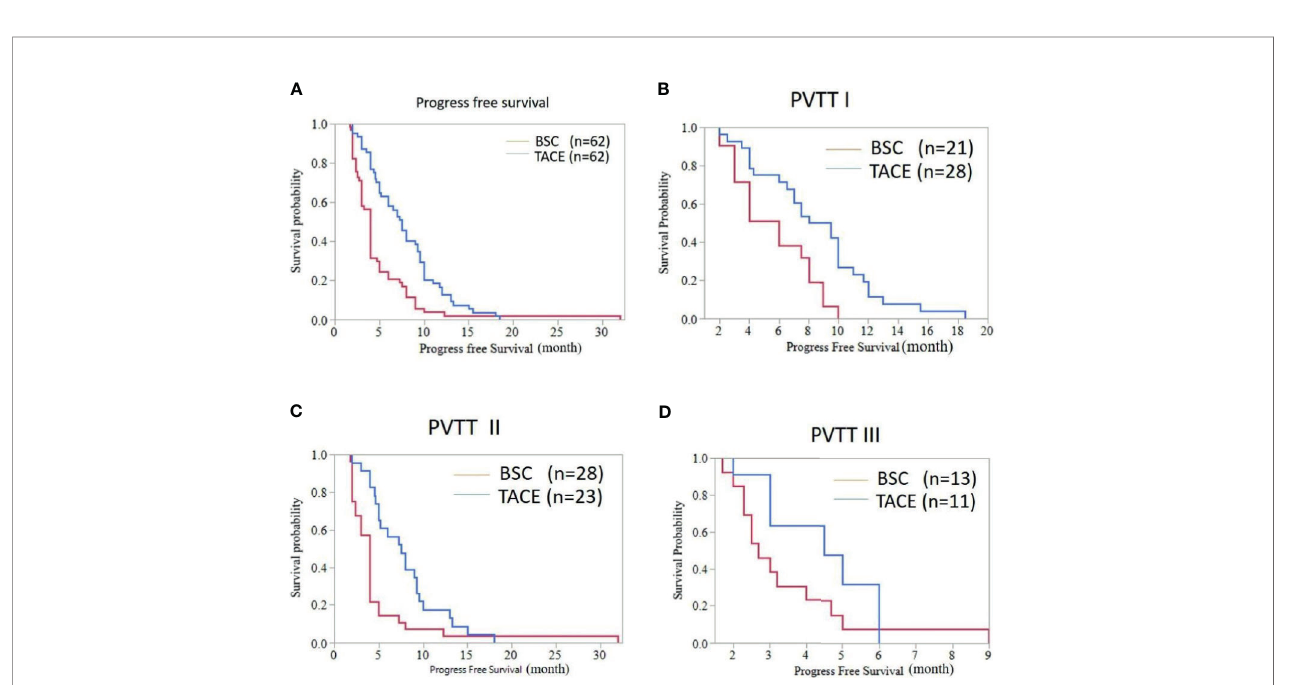
FIGURE 3 | Progress free survival curve of HCC patients with PVTT accepting the TACE or BSC treatment. (A) Whole population (median PFS [months], 7.50 (6.284-8.716) vs. 4.00 (3.625-4.375); P < 0.001). (B) Patients with type I PVTT (PFS, 8.00 (5.485-10.515) vs. 6.00 (3.973-8.027); P =0.003). (C) Patients with type II PVTT (PFS, 7.50(5.152-9.848) vs. 4.00 (3.574-4.426); P =0.005). (D) Patients with type III PVTT (PFS, 4.50 (2.337-6.663) vs. 2.70 (2.083-3.317); P